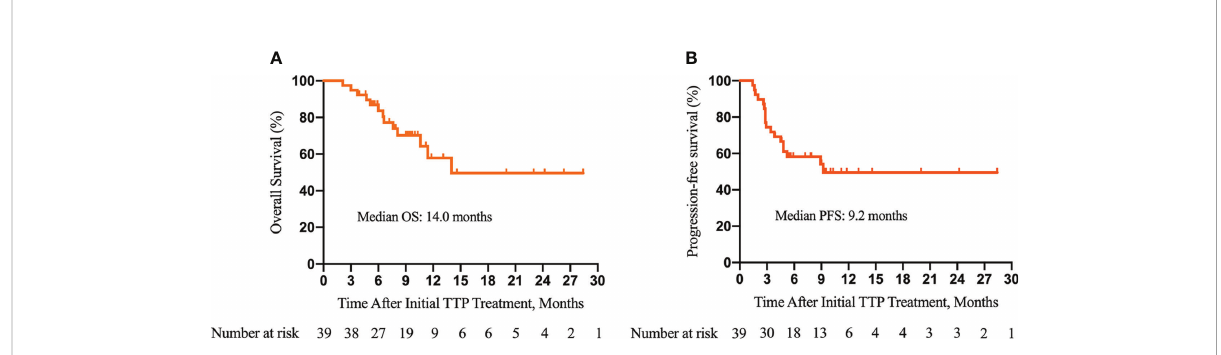
FIGURE 2 Kaplan – Meier survival curves of overall survival (OS) (A) and progression-free survival (PFS) (B) of patients with unresectable hepatocellular carcinoma and portal vein tumor thrombus (PVTT) who underwent the triple therapy. TTP, transarterial chemoembolization (TACE) plus antiangiogenic-targeted treatment and anti-PD-1 inhibitors.